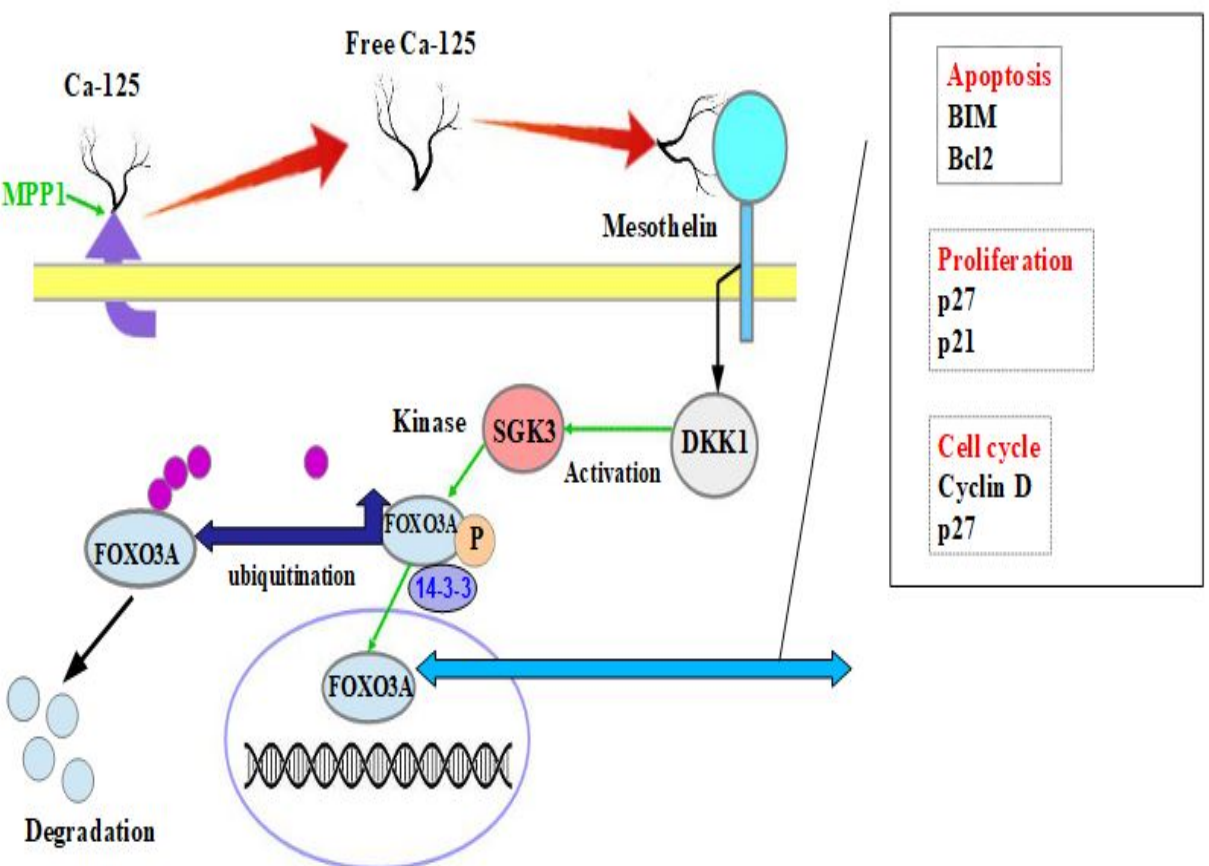
Figure 2. Schematic and simplified representation of the pathway involving the binding of CA125 with mesothelin for the migration of neoplastic cells and metastatic diffusion in advanced serous ovarian carcinoma.